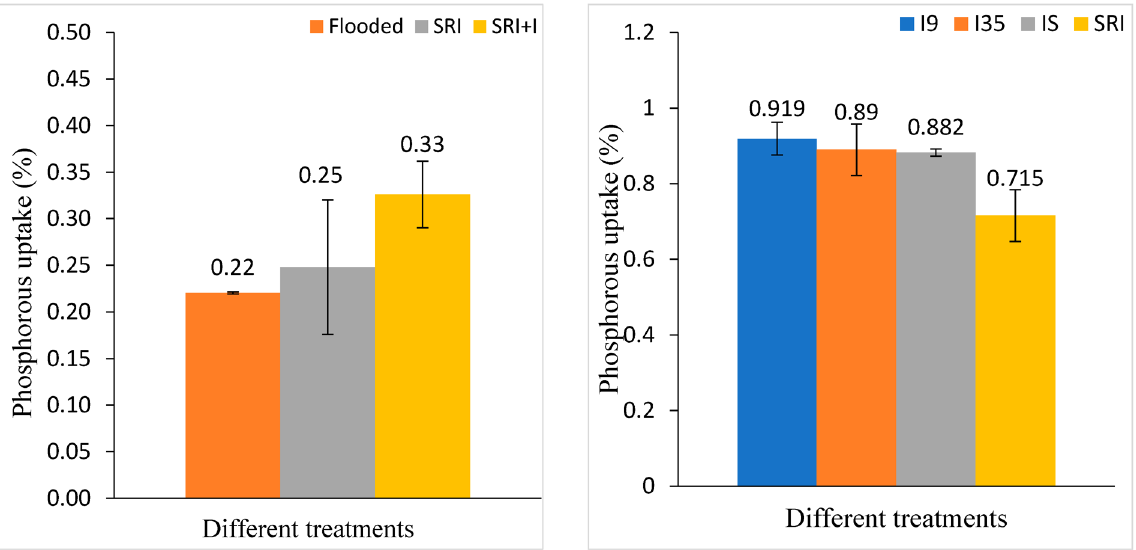
Figure 11. Phosphorous uptake as measured in the different treatments. Conventional flooded rice (CFR), SRI, and SRI with intercropping (SRI+I or SRIBI) in 2017 ( Left ). SRI and three different intercropping configurations in 2018 ( Right ).